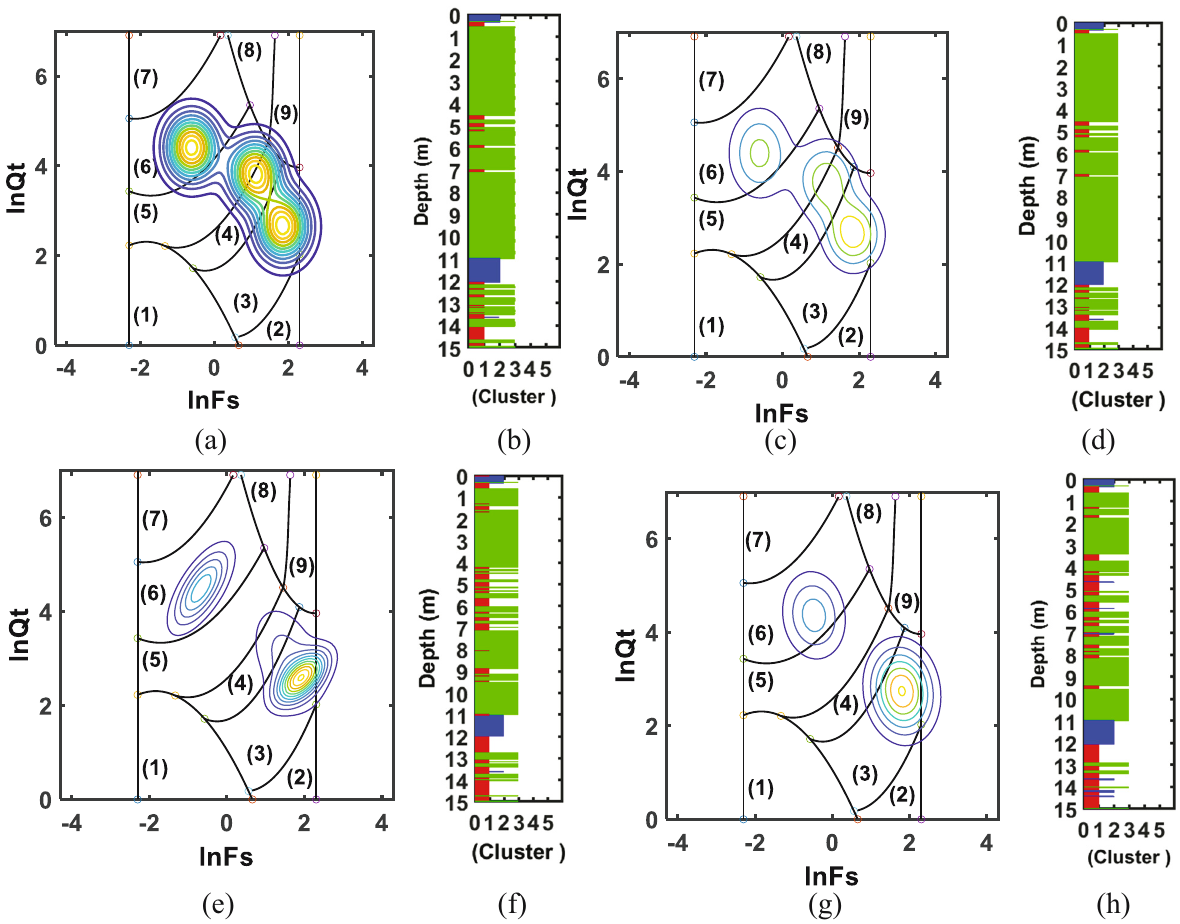
Figure 7: Three cluster model, in three model forms, for four cases of covariance: ( a ) Robertson chart, true DC, three clusters; ( b ) physical patterns; ( c ) Robertson chart, false full covariance, three clusters; ( d ) physical patterns; ( e ) Robertson chart, false DC, three clusters; ( f ) physical patterns; ( g ) Robertson chart, unshared full covariance, three clusters; and ( h ) physical